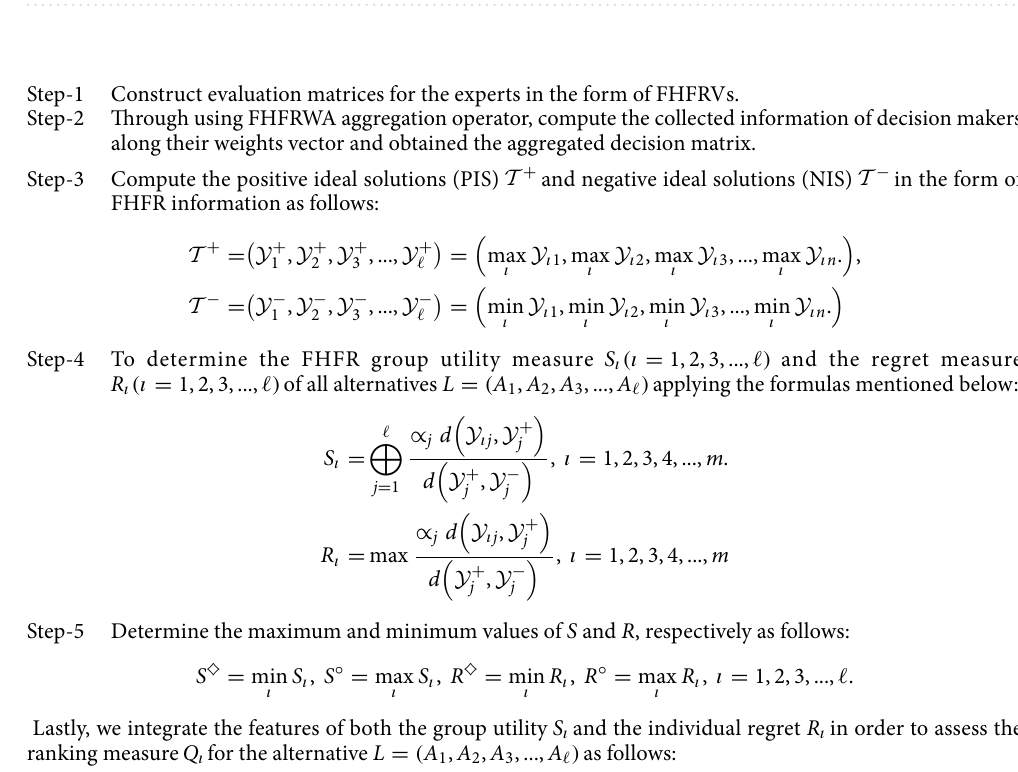
Figure 2. The pictorial diagram of the ranking of underdeveloped